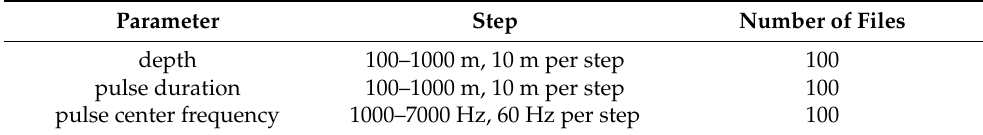
Table 3. Dataset Table 3. Dataset configuration.